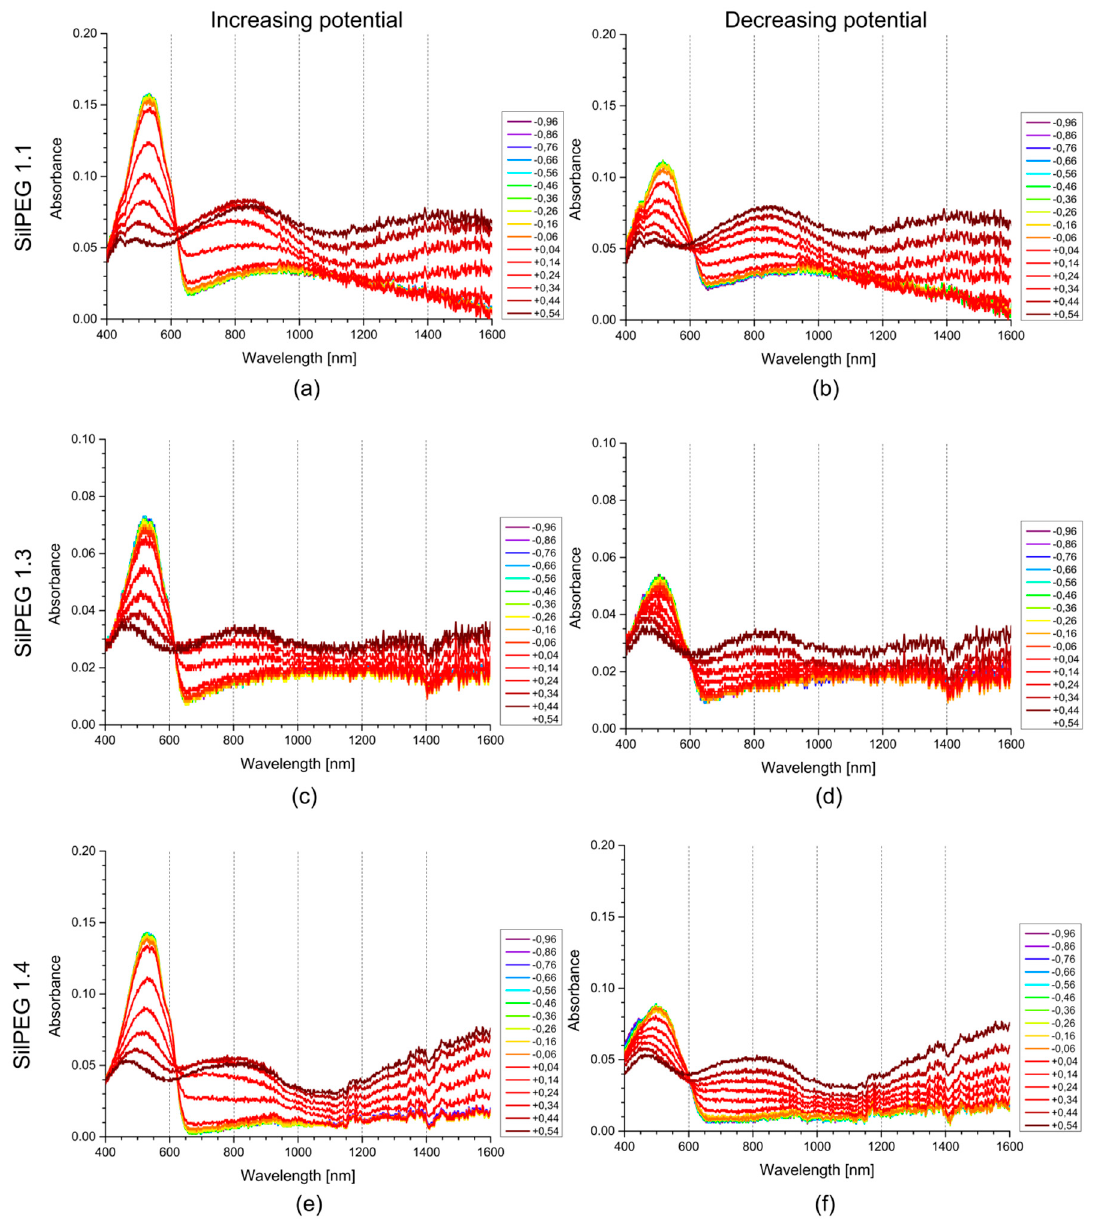
Figure A8. UV-Vis-NIR spectra recorded during the application of stepwise increasing (left) and decreasing (right) potential (vs. Ag/Ag+) to films of the investigated polymer and copolymer: ( a , b ) SilPEG 1.1; ( c , d ) SilPEG 1.3; ( e , f ) SilPEG 1.4 deposited on ITO/quartz electrodes.